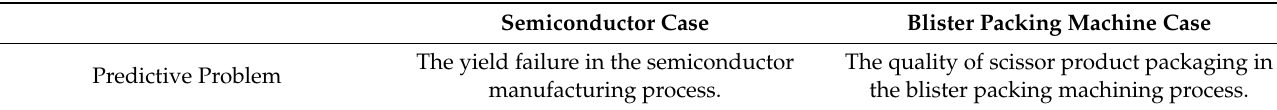
Table 4. List of case studies.